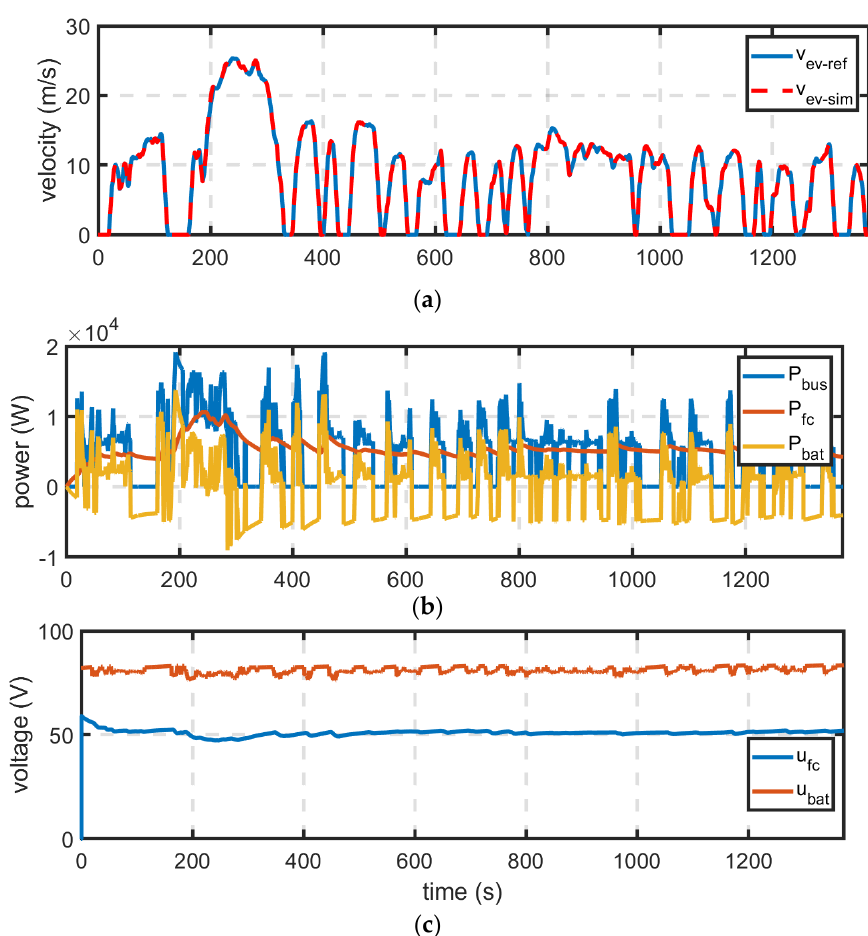
Figure 11. Vehicle simulation results for FTP-72 cycle under D-ECMS: ( a ) Profile on vehicle’s reference and actual velocity; ( b ) power variation of bus, fuel cell, and battery with time; ( c ) voltage variation of fuel cell and battery.